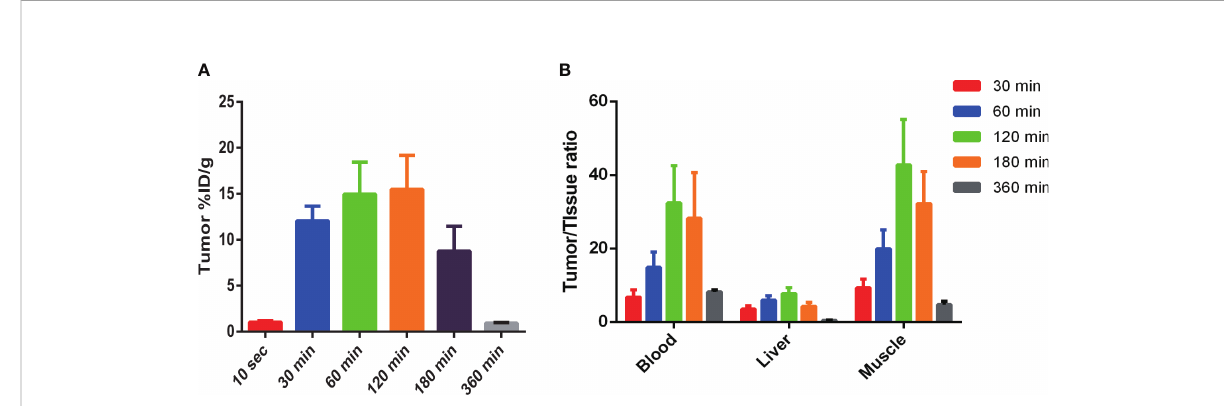
FIGURE 6 99m Tc-PDA uptake in MC38-B7H1 tumors (A) and comparison of 99m Tc-PDA in tumor to tissue (B) . (A) Tumor uptake was signi fi cantly higher at all time points after 30 min than 10 s post- 99m Tc-PDA injection ( P < 0.01). (B) Signi fi cant difference in tumor-to-blood ratios were observed at 30 min vs. 120 min and 60 min vs. 120 min after injection ( P < 0.01); the tumor-to-liver ratios were signi fi cantly higher at 120 min compared to 30 and 180 min ( P < 0.01), and the tumor-to-muscle ratios were signi fi cantly higher at 120 min compared to 30 and 60